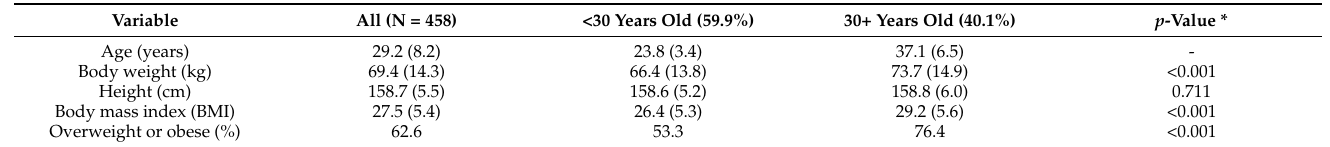
Table 1. Anthropometric measurements of the participating females (means and standard deviations).